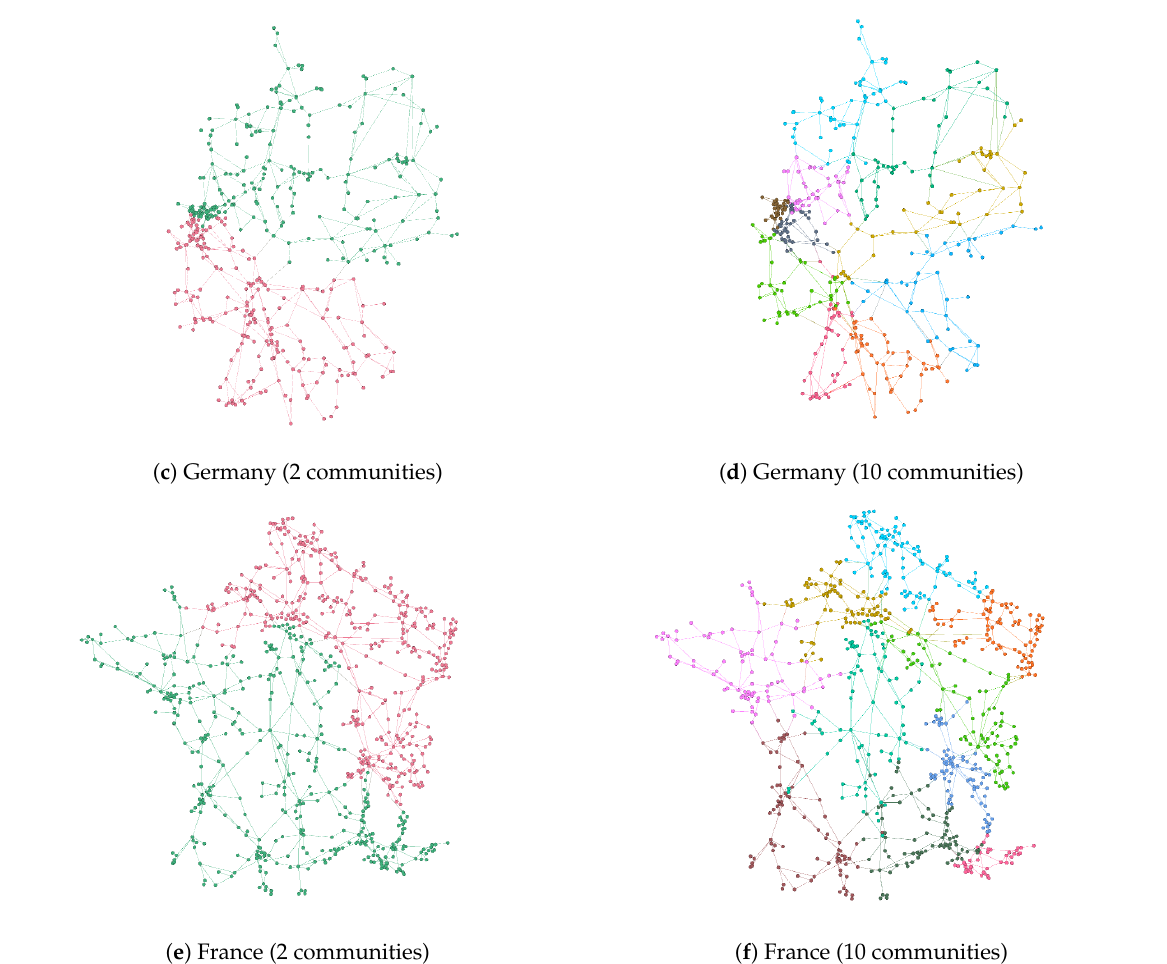
Figure 4. Communities detected in the networks representing the power grids of Italy, Germany, and France considering 2 and 10 communities.